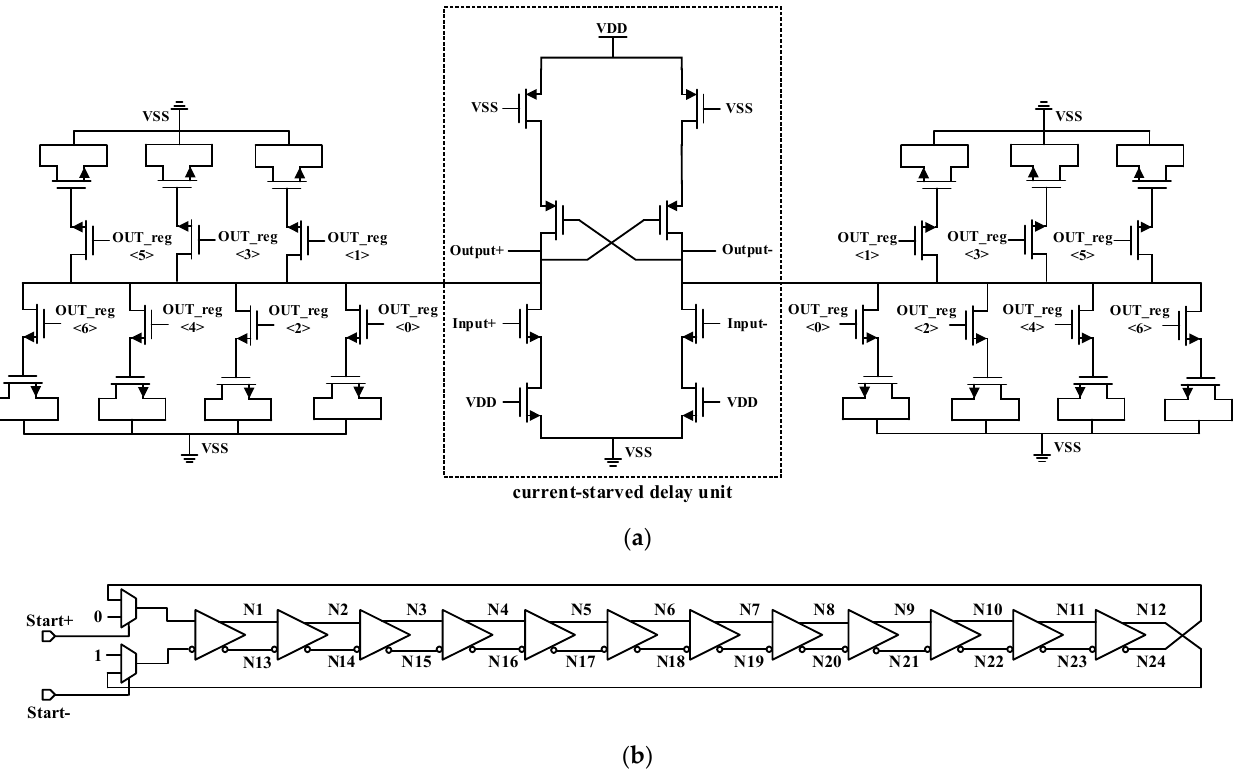
Figure 7. ( a ) A digitally controlled symmetrical current-starved delay unit; ( b ) Diagram of the delay line in Vernier TDC. line in Vernier